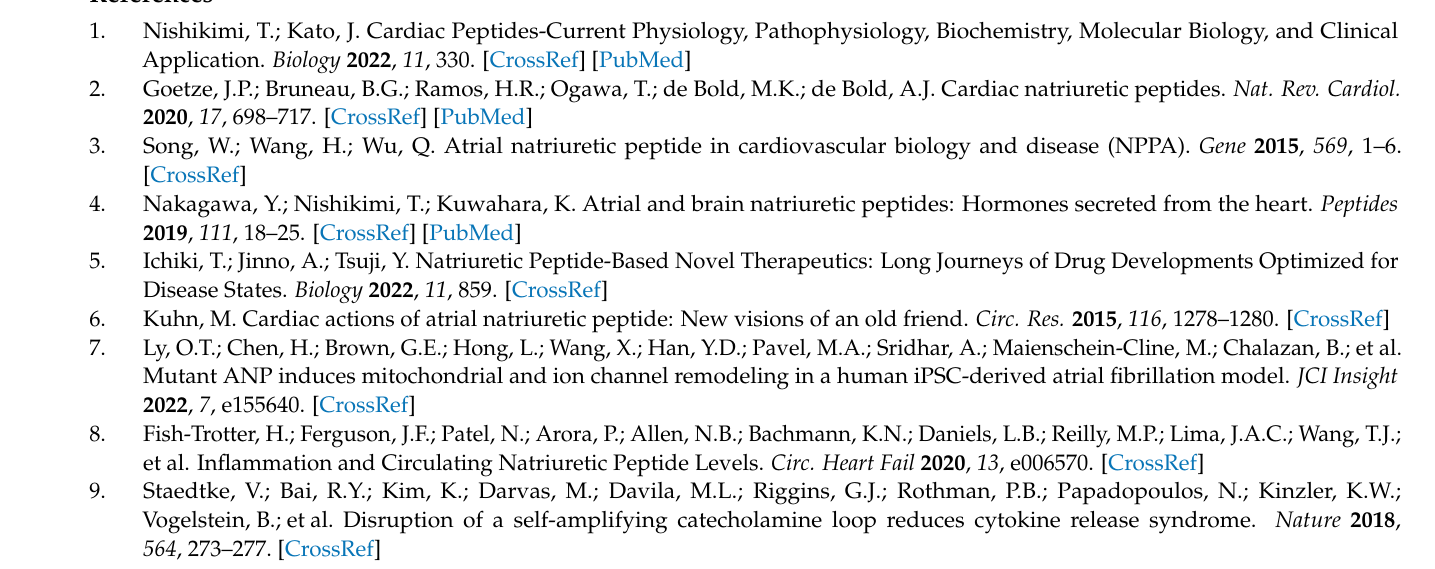
Body weight gains in female WT and corin KO mice, Figure S3: Data of additional adipose tissue weights in WT and corin KO mice, Figure S4: Ucp1 mRNA levels in ingWAT from WT and corin KO mice, Figure S5: Additional metabolic data from WT and corin KO mice, Figure S6: Ucp1 staining intensities in ingWAT and iBAT from WT and corin KO mice, Figure S7: Cardiac Corin and Nppa mRNA levels in corin KO mice, Figure S8: Uncropped gel images of Figure 6A, Figure S9: Uncropped western blot images and relevant intensities of bands in Figure 6C, Figure S10: Uncropped gel images of Figure 7B, Table S1: Primers used in